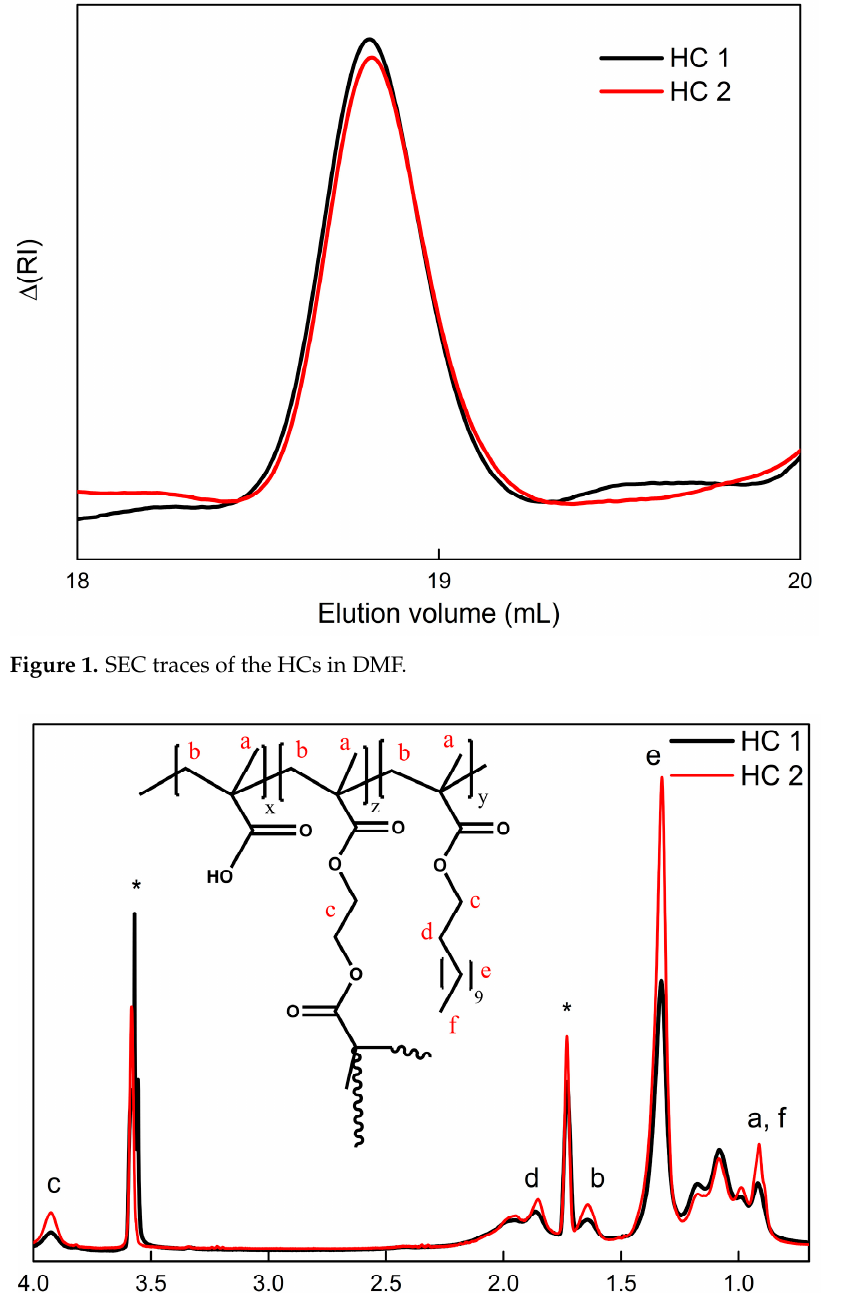
Figure 3. FTIR spectra of the HCs in solid state. 3.2. Self-Assembly Studies 3.2.1. CAC Determination The fi rst step to investigate the ability of the HCs to self-assemble into PNPs was a series of fl uorescence spectroscopy experiments to determine whether the HCs present a critical aggregation concentration (CAC). At very low concentrations in aqueous solu- tions, amphiphilic copolymers reside as freely dispersed polymer chains. Increasing the concentration causes an increase in the thermodynamically non-bene fi cial interactions be- tween hydrophobic moieties and water molecules, forcing the copolymers to self-assem- ble [51]. CAC or the lowest (critical) concentration in which the copolymers begin to self- assemble provide important information about the copolymers’ system stability and as- sociation, since low CAC values foreshadow higher integrity upon extended dilution in the bloodstream [52]. Pyrene, which exhibits characteristic emission spectra that is